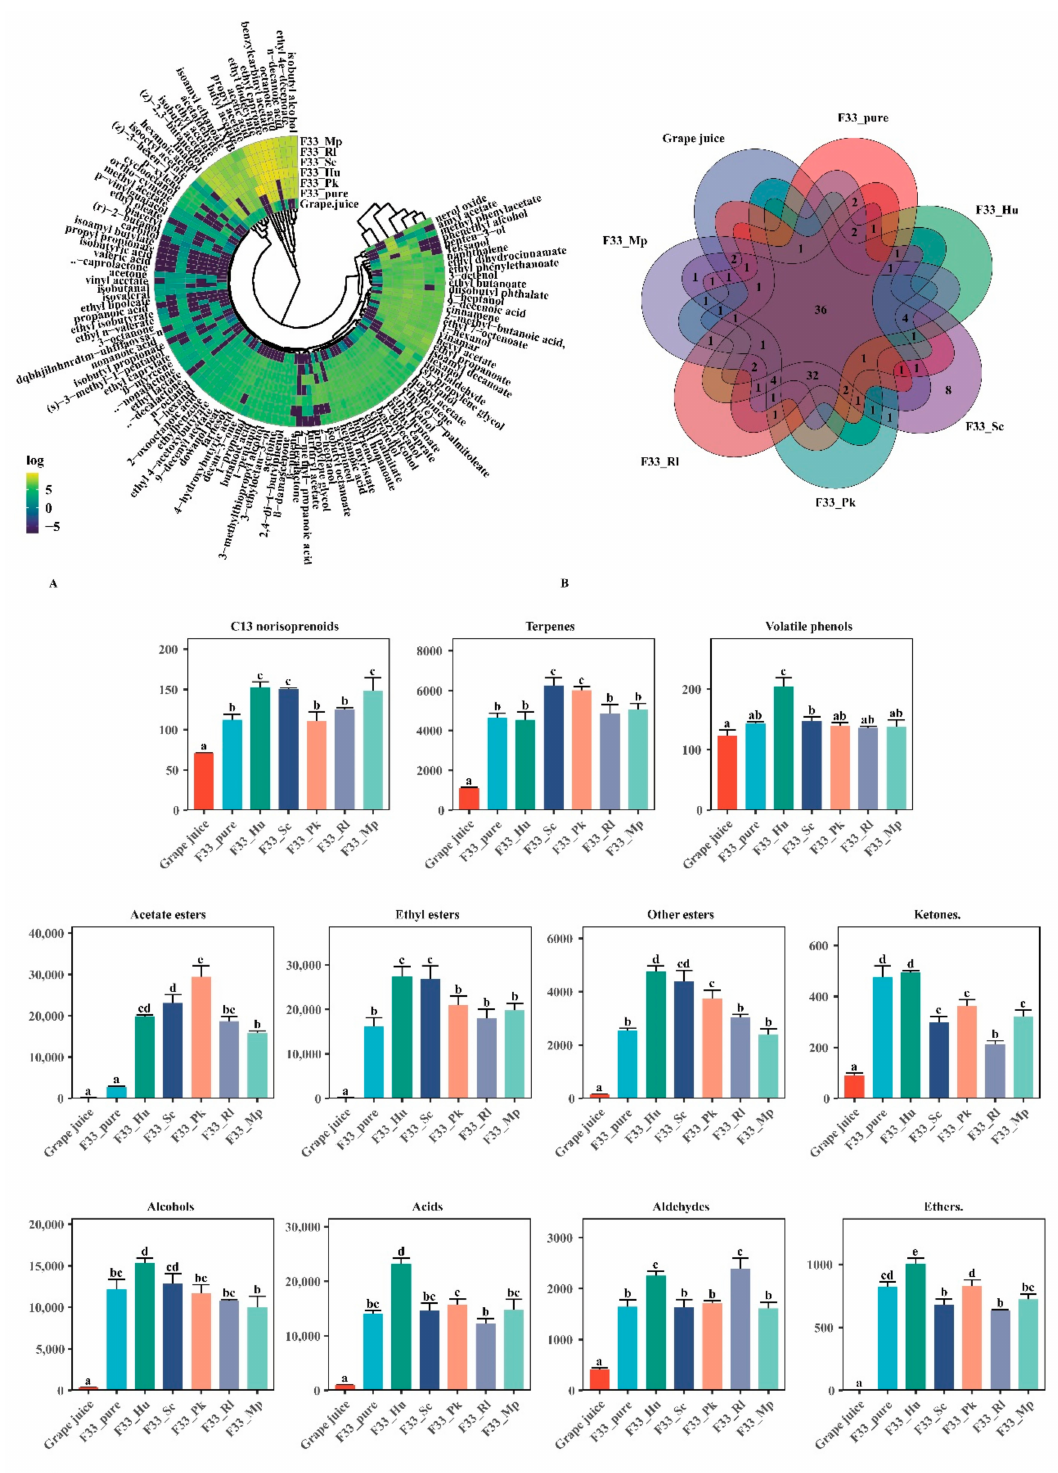
Figure 5. Volatile compounds from Vidal grape juice and icewines fermented with six fermentation strategies. pure_F33: S. cerevisiae F33 monoculture. F33_Hu: co-inoculation of S. cerevisiae F33 and H. uvarum QTX22. F33_Sc: co-inoculation of S. cerevisiae F33 and S. crataegensis Y30. F33_Mp: co-inoculation of S. cerevisiae F33 and M. pulcherrima YC15. F33_Pk: co-inoculation of S. cerevisiae F33 and P. kluyveri HSP11. F33_Rl: co-inoculation of S. cerevisiae F33 and R. lusitaniae QTX26. ( A ) Pheatmap clustering graph of all the individual volatile substances. Yellow: relatively high production; Black: relatively low production. Count represents the standardized content aroma-active compounds. ( B ) Venn diagram showing the distribution of the numbers of the aroma compounds. ( C ) Column diagram showing the content distribution of the aroma categories. Different letters indicate statistically significant